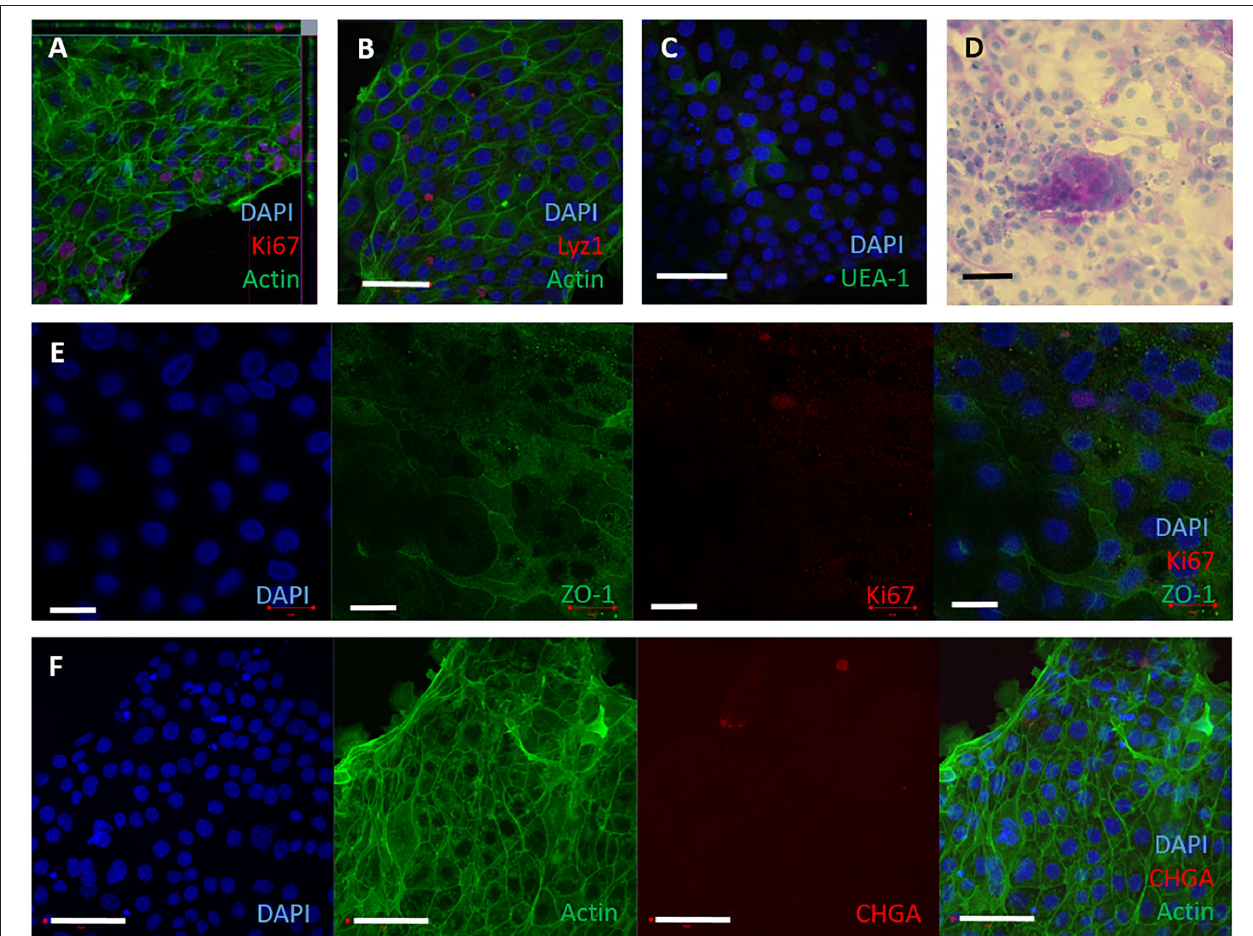
FIGURE 2 | 2D epithelial monolayers cultured on collagen matrix. Single cells were seeded onto collagen coated wells. The 2D monolayers were cultured with IntestiCult containing the relevant inhibitors and maintained for up to 10 days. (A–F) Representative confocal microscopy images of 2D monolayers cultured on collagen coated wells from 3 separate amimals, demonstrating presence of specific cell marker proteins. (A) F-actin (phalloidin, green), nuclei (DAPI, blue) and proliferative cells (Ki67, red). (B) Nuclei (DAPI, blue), F-actin (Phalloidin, green) and Paneth cells (lysozyme, red). (C) Nuclei (DAPI, blue) and glycolipids (UEA-1, green). (D) 2D monolayer imaged by brightfield microscopy stained for Periodic Acid Schiff to show mucins produced by goblet cells. (E) Split panel of monolayer stained for nuclei (DAPI, blue), tight junctions between cells (ZO-1, green), and proliferative cells (Ki-67, red). Scale bar = 20 µ m. (F) Split panel of monolayer stained for nuclei (DAPI, blue), F-actin (Phalloidin, green) and enteroendocrine cells (chromogranin A, red). Scale bar = 50 µ